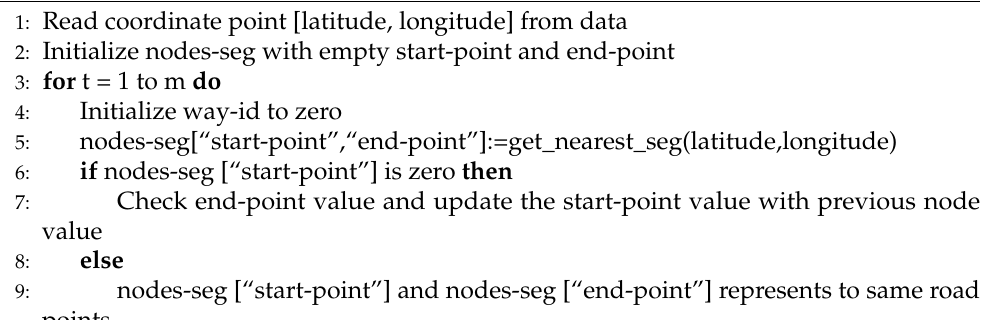
Algorithm 1 Preprocessing and Data Integration